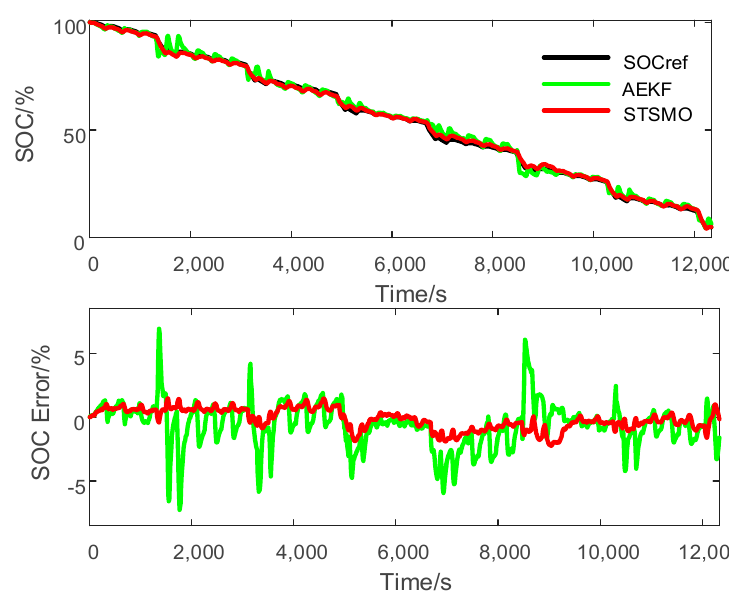
Figure 15. SOC estimation for 0.5 C pulse current discharge (PCD) profile.